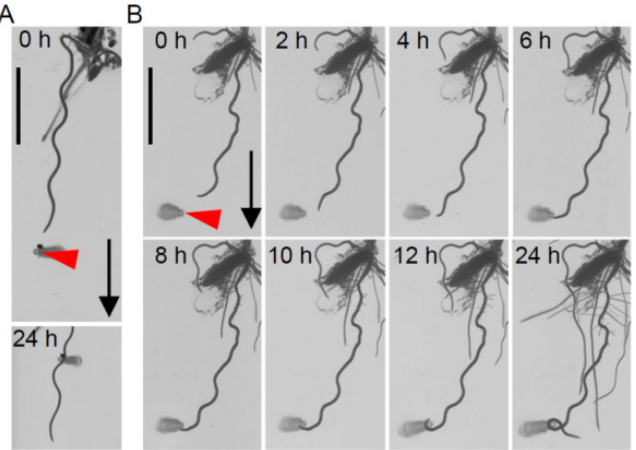
Figure 1. Nutritropic bioassay in rice main roots. The images show examples of nutritropic bioassay for the qualitative evaluation of nutritropic responses in main roots. Main roots of rice seedlings cultivated in culture agar media were assayed with nutrient sources containing 200 mM of NH 4+ , NO 3+ , K + , and/or P i . Nutrient sources (red arrowheads) were inserted in the direction of the elongation vector at the 3–5 mm distance from the main root tips. Growth responses of the main roots after 24 h were defined as the following two behaviors; ( A ) passed by or ( B ) coiled more than once at the inserted nutrient sources. WRC1 and WRC25 were used as examples in ( A , B ), respectively. Both accessions were cultivated in 1/200 diluted MS medium (pH 5.7–5.8) supplemented with 2% ( w/v ) sucrose, 0.05% ( v/v ) Plant Preservative Mixture, and 1.5% ( w/v ) agar. Black arrow,